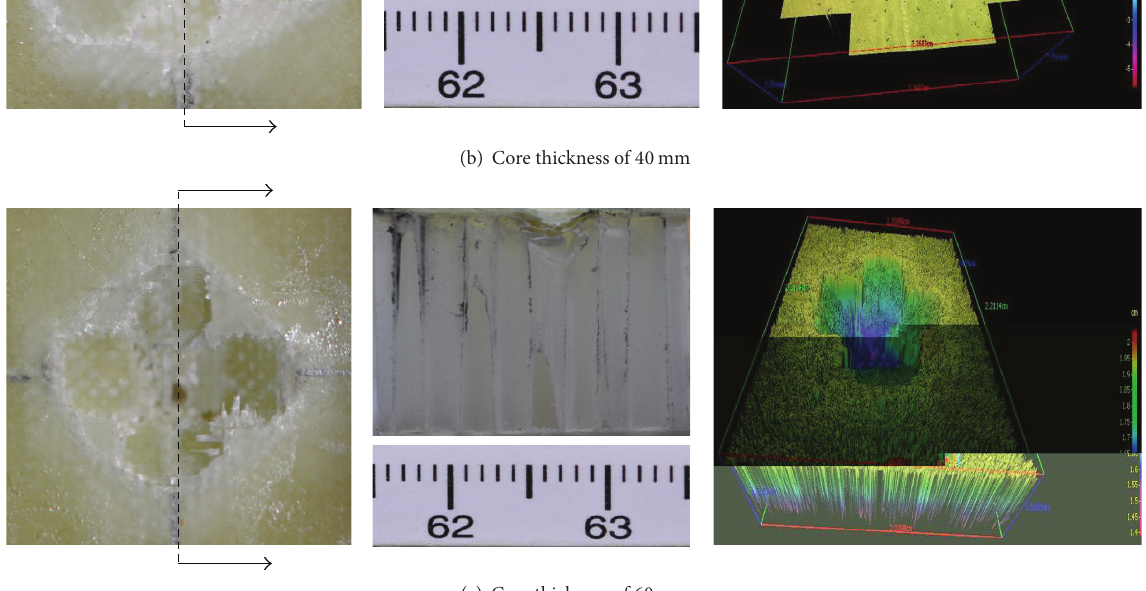
Figure 13: Impacted surfaces, cross-section views, and optical surface metrology of the sandwiches subjected to 45 J of IKE.